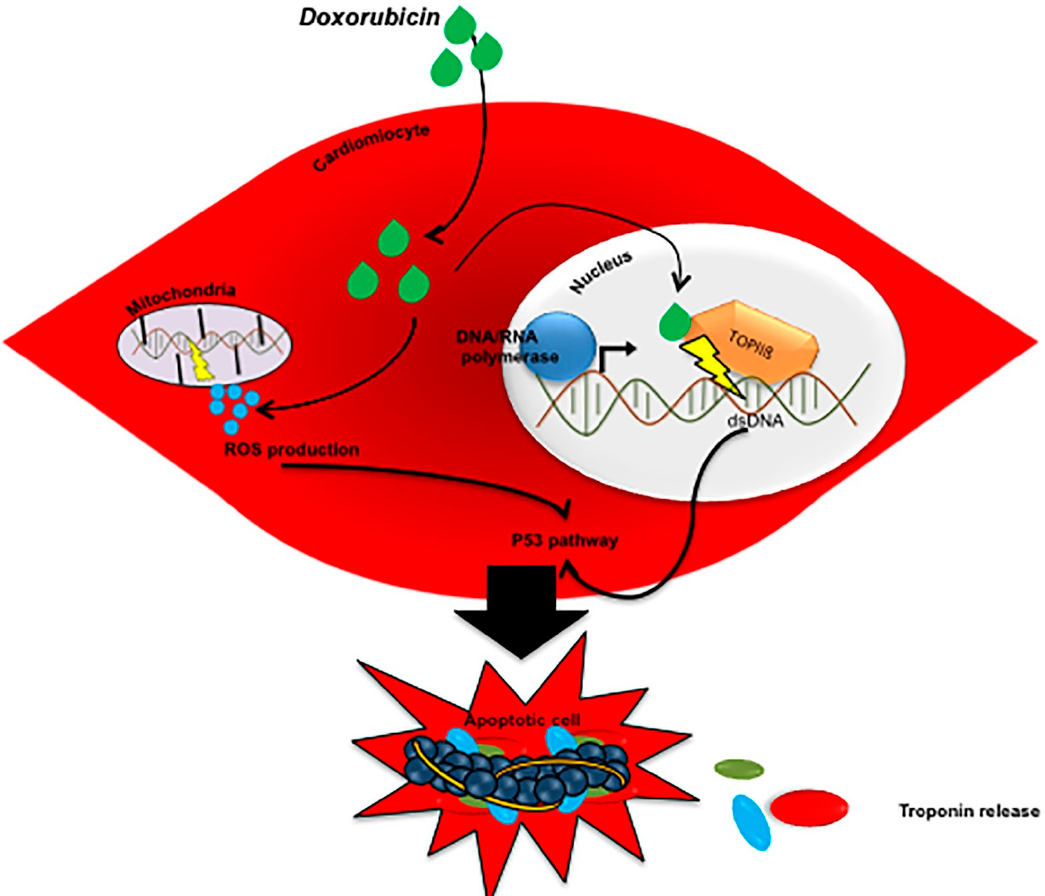
Figure 3. Mechanism of troponin release caused by anthracyclines [27].